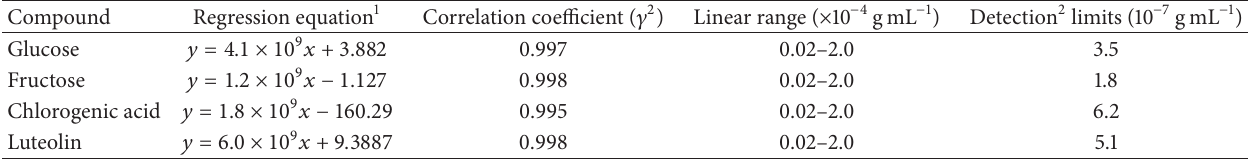
Table 2: Results of the regression analysis on the calibration curves and the detection limits.